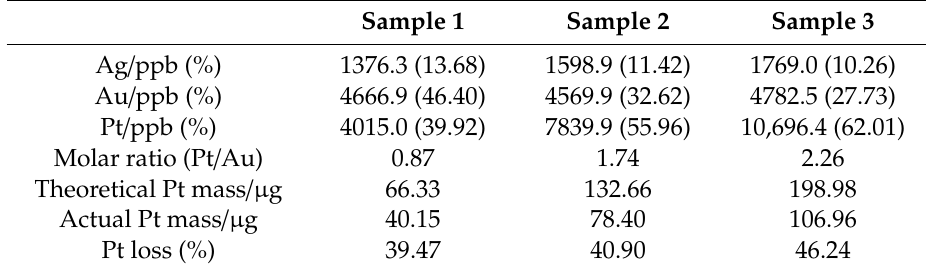
Figure 4. Plots of the Pt / Au molar ratio of Pt nanocluster-anchored hollow Ag-Au nanostructures at actual value (black line) and theoretical value (red line) against the injected Pt / Au molar ratio. Table 1. Compositional information of Pt nanocluster-anchored hollow Ag-Au nanostructures with injected molar ratios of Pt / Au from 1 to 3 confirmed by